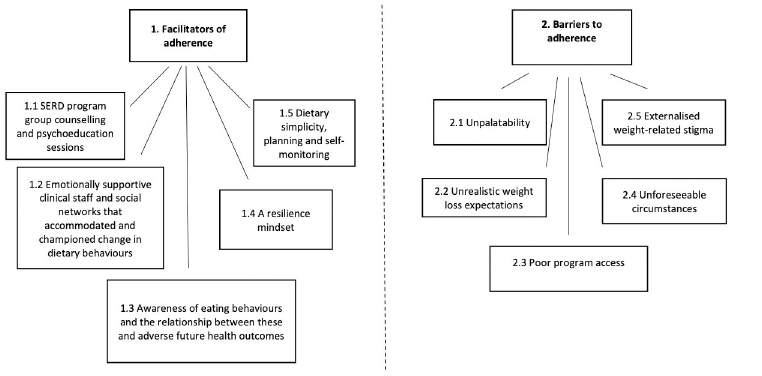
Fig 1. Facilitators and barriers to